Question: What style of plot is this figure drawn as?
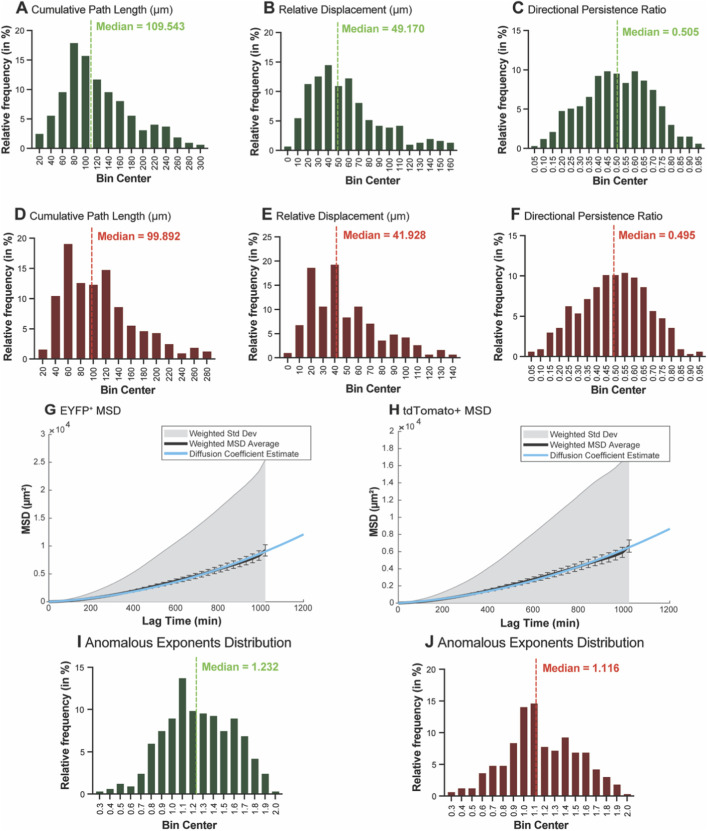
Answer: histogram